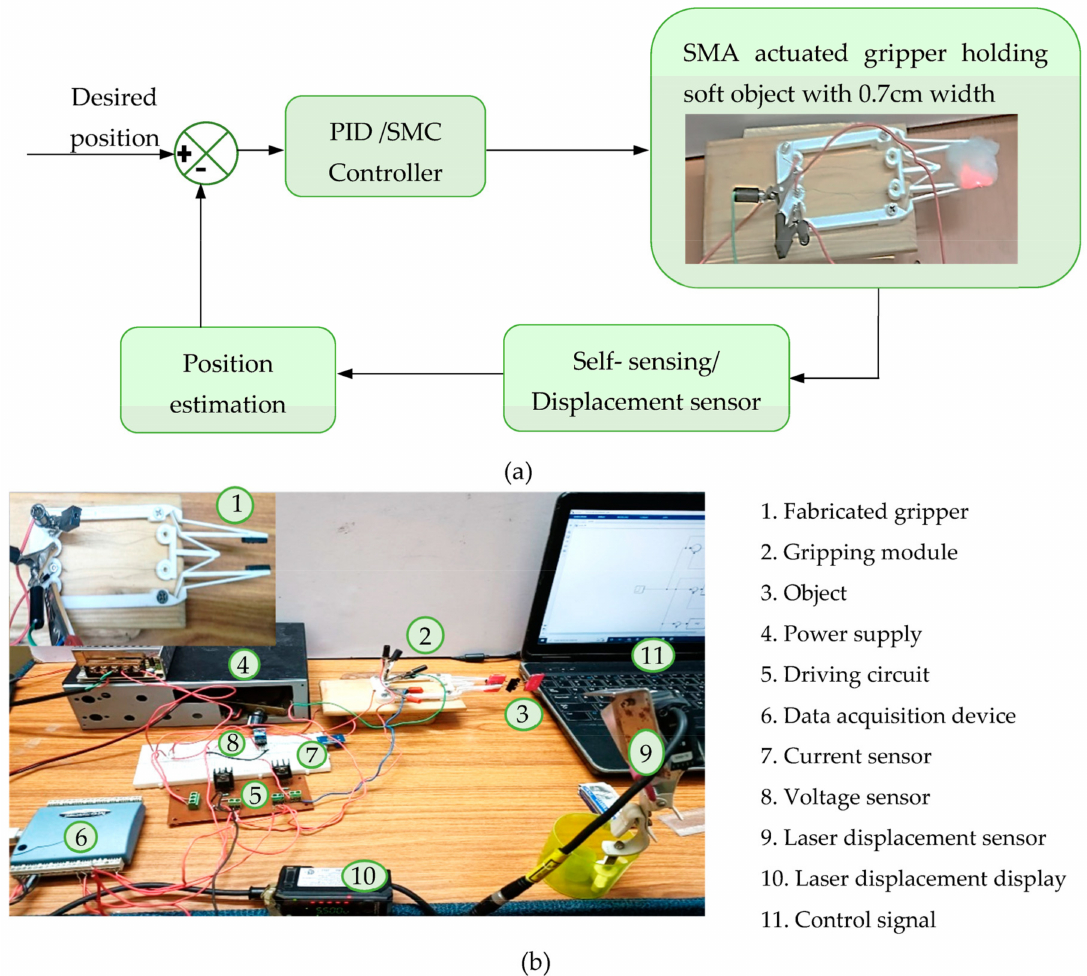
Figure 11. Implementation of control strategy: ( a ) schematic, ( b ) experimental